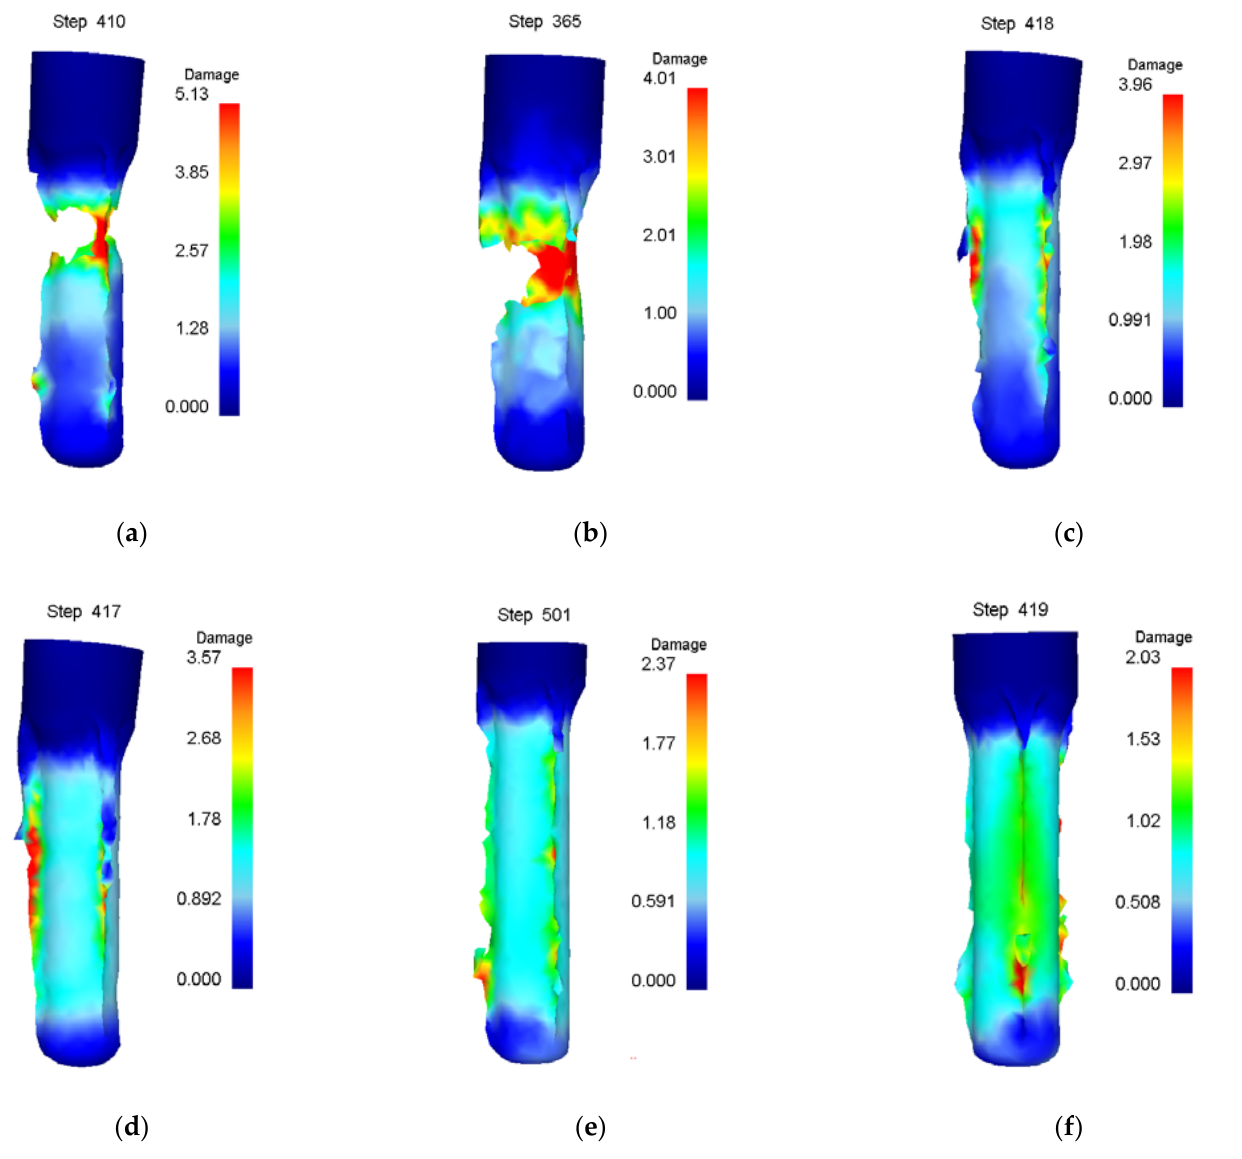
Figure 14. Damage value distribution of different roller radiuses of ( a ) 70 mm; ( b ) 75 mm; ( c ) 80 mm; ( d ) 85 mm; ( e ) 90 mm; ( f ) 95 mm. Table 4. Simulation results of different roller radiuses.